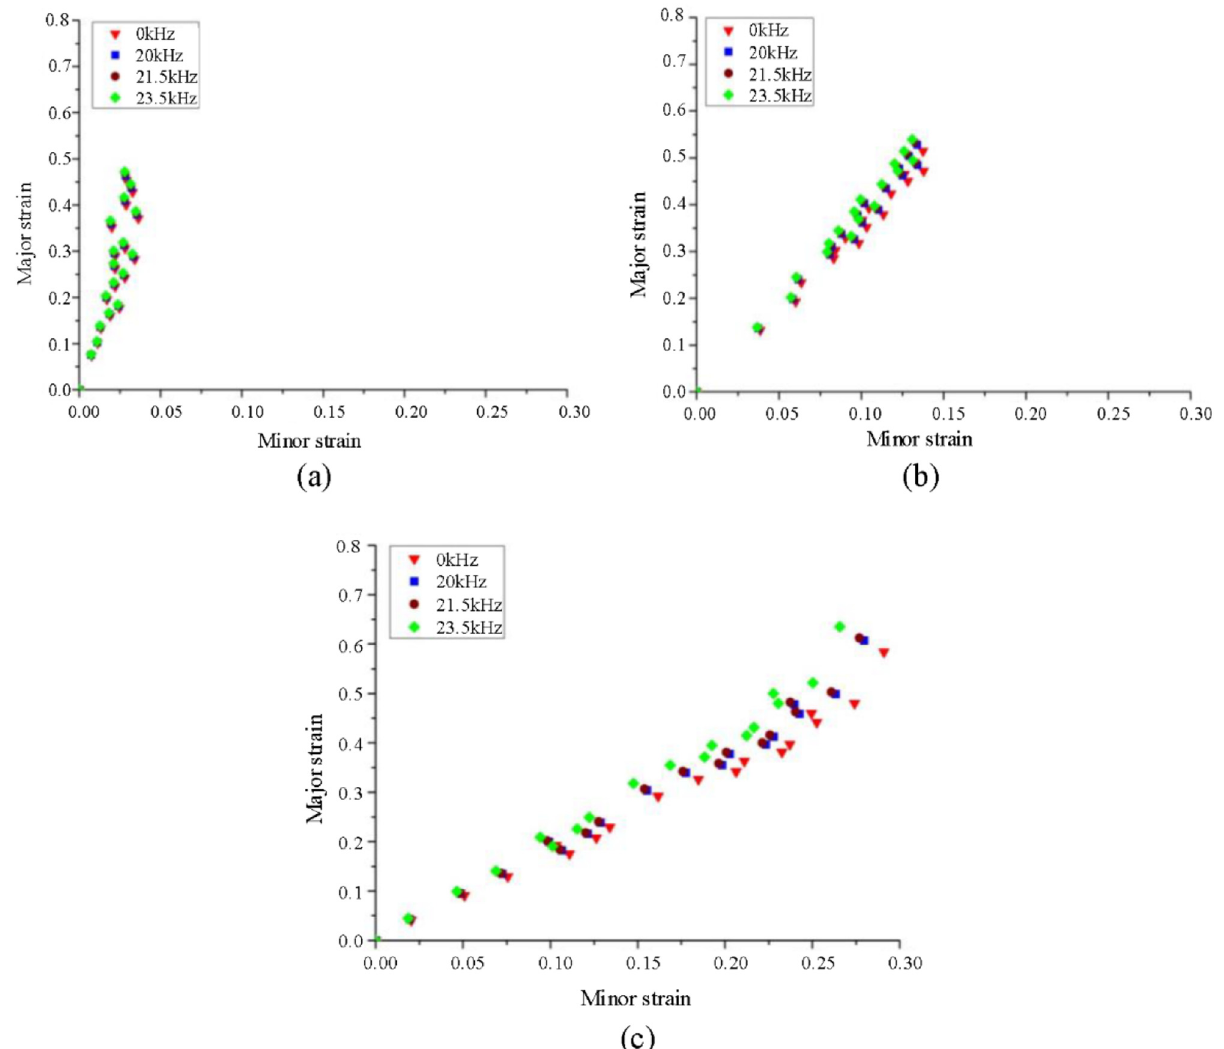
Fig. 10. Bulging-forming limit strain of different specimens under ultrasonic vibration. (a) spec1. (b) spec2. (c)